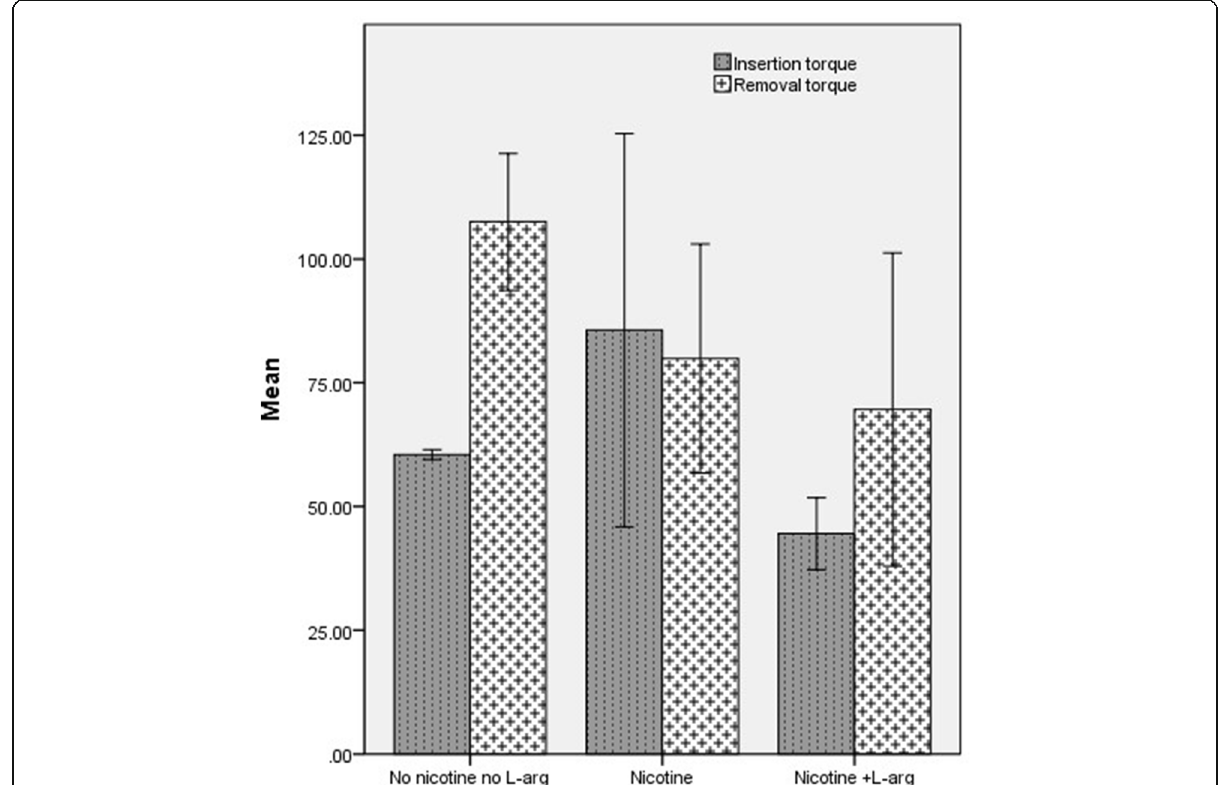
Fig. 3 The mean of torque at insertion and removal time in the three